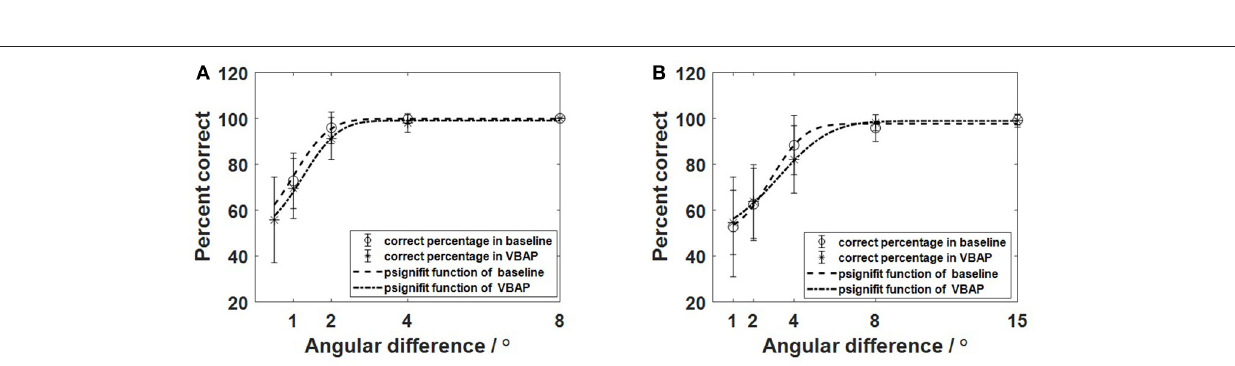
FIGURE 4 | The percentage of correct answers fitted by psignifit function in the baseline (dash line) and the VBAP method (dash-dot line). (A) The results of the front MAA measurement experiment; (B) The results of the lateral MAA measurement experiment.